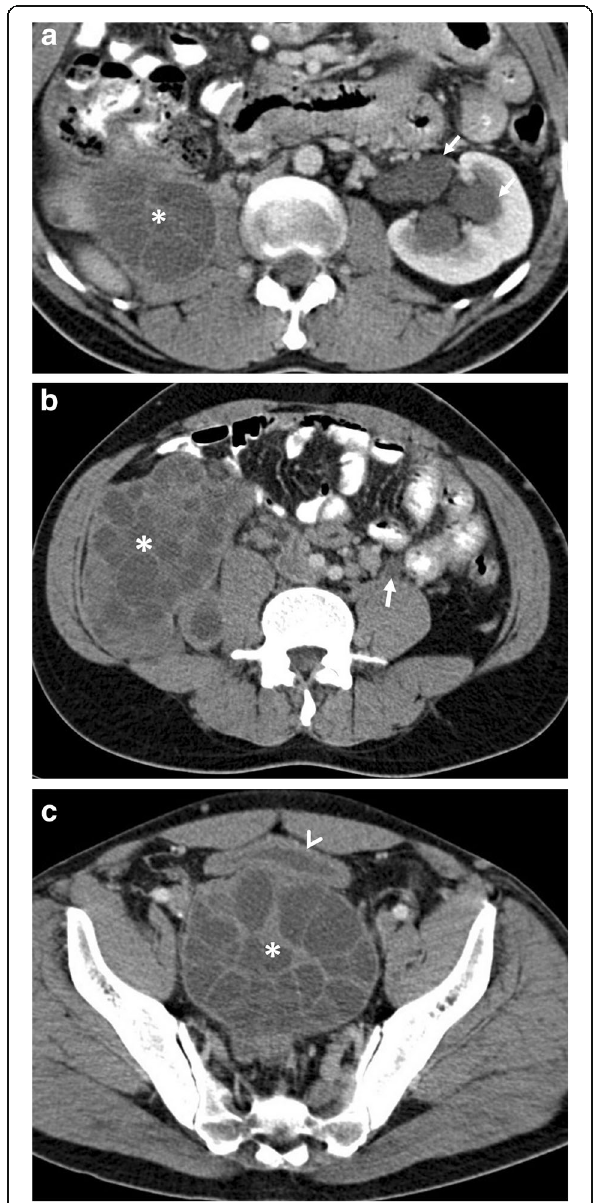
Fig. 7 A 25-year-old man presented to the emergency department with a 1-week history of fever, voiding difficulty, and bilateral